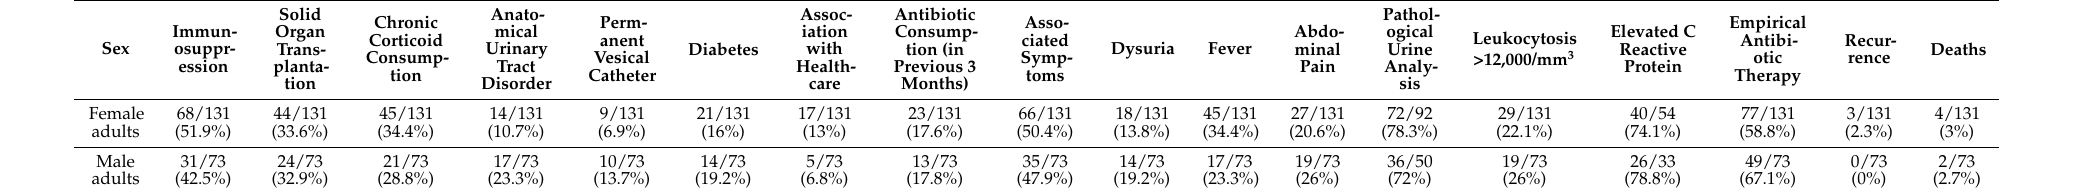
Table 3. Epidemiological and clinical variables corresponding to urinary infection episodes in male and female